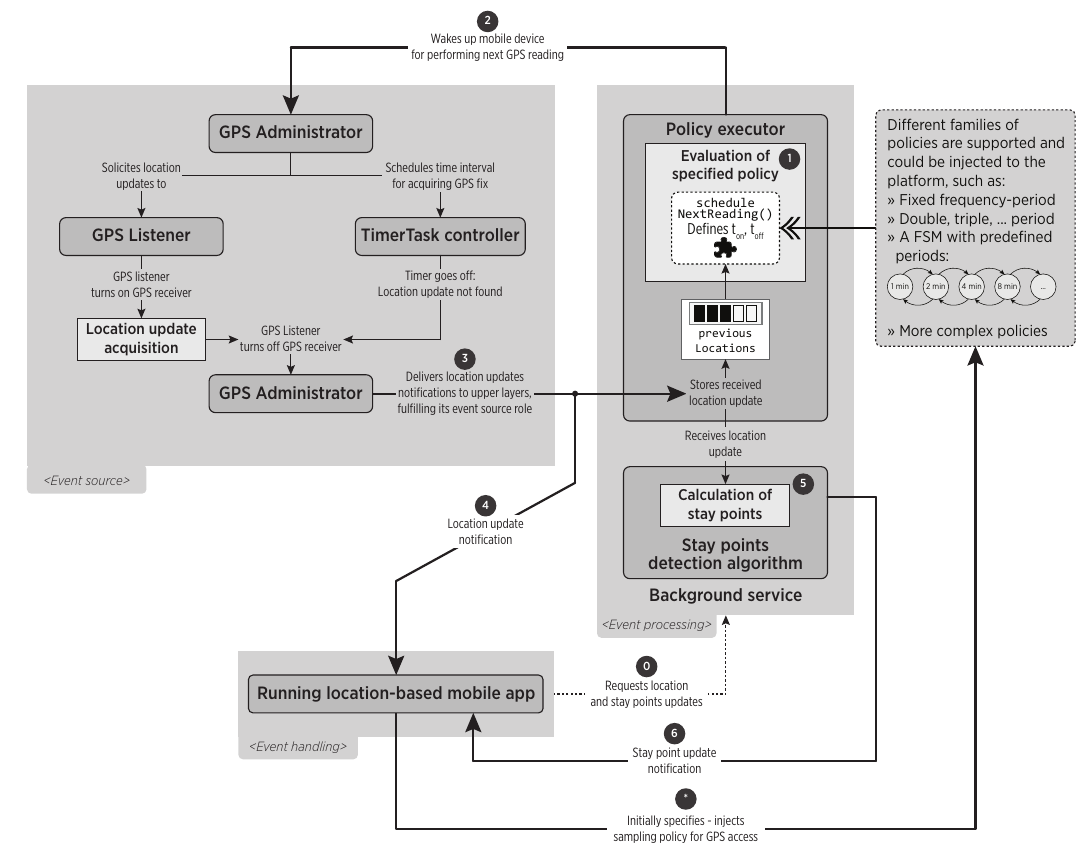
Figure 4. Interaction between components and information flow across tasks executions. Components are provided by the middleware itself, with the exception of the policy (shown as dotted) that could be injected by an additional entity, such as the hosted mobile